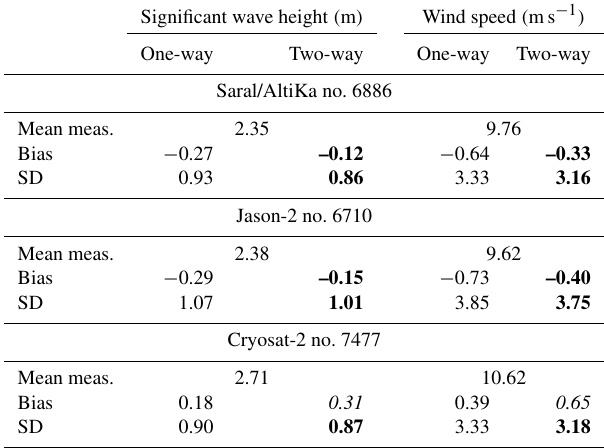
Table 1. Bias and standard deviation of validation of wind speed (ms − 1 ) and significant wave height (m) of the one- and two- way coupled models against the available satellite data over the whole period (measured minus modelled). Bold means an improve- ment of the two-way coupled model skills; italic means that the one-way coupled model skill is better than the ones of the two-way coupled